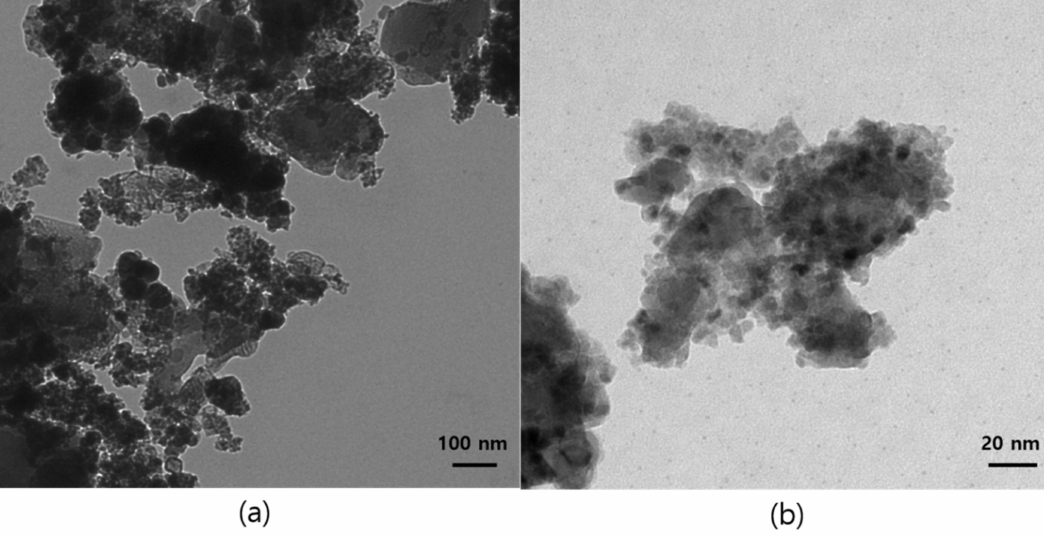
Figure 5. TEM images of NiOLa-04 nanoparticles: ( a ) 100 nm magnification; ( b ) 20 nm